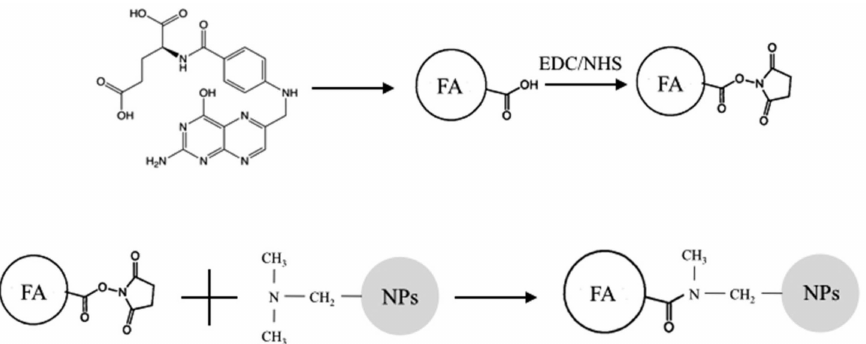
Figure 1. Schematic of the coupling reaction between folic acid (FA) and terpolymer-based nanopar- ticles (NPs). Activation of carboxylic groups of FA (chemical structure shown at the top right) by EDC/NHS; formation of covalent bonds among activated esters of FA and tertiary amine of DMAEMA monomer units of terpolymer-based